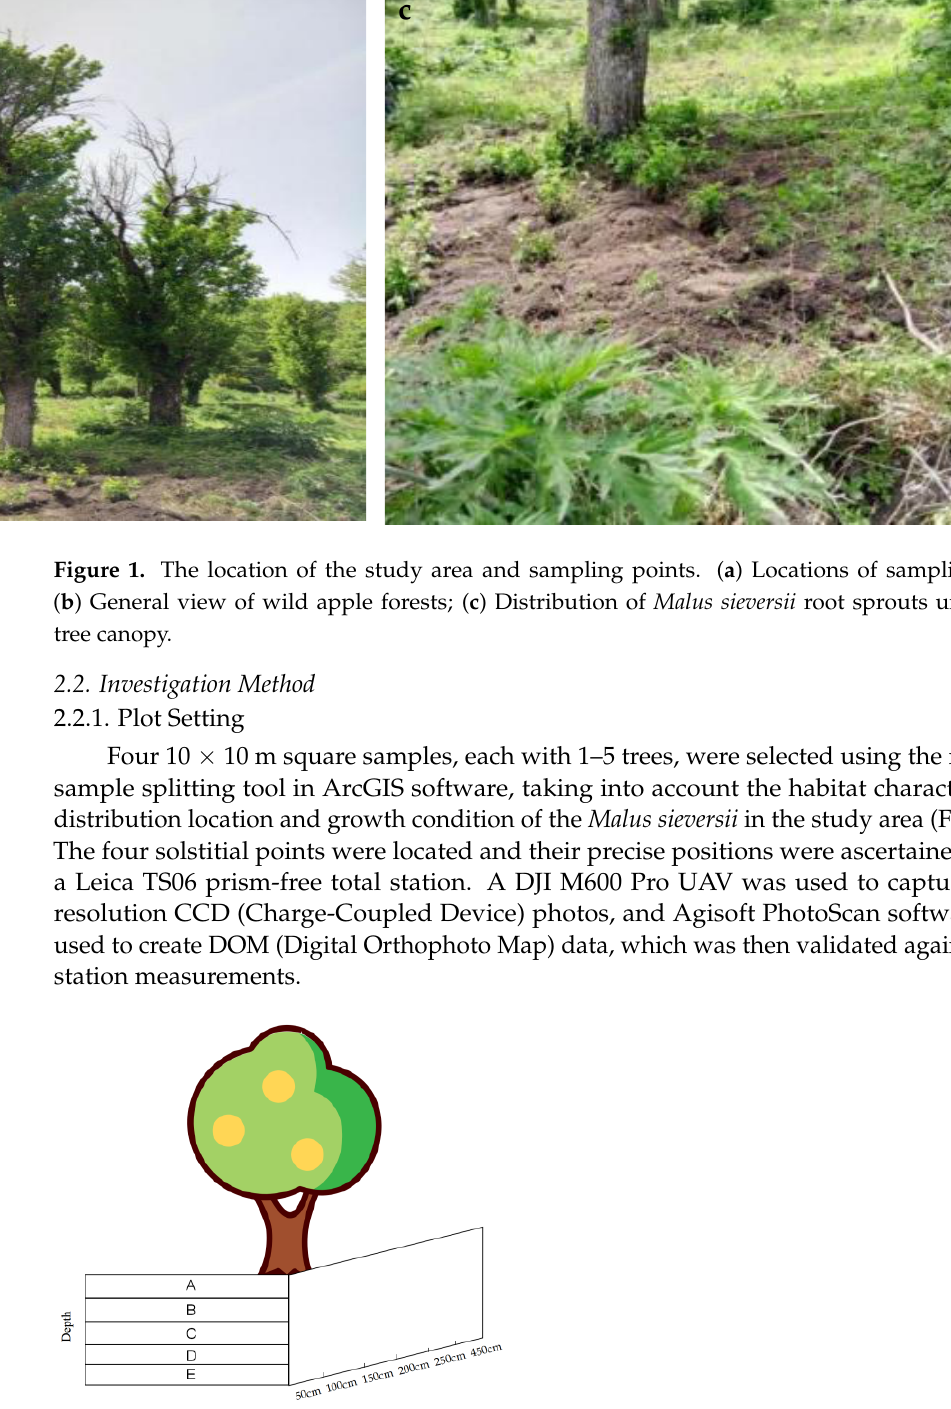
Figure 2. Root survey sample. (A–E represent the depth of root burial in five profiles, respectively: <5 cm, 6–20 cm, 21–40 cm, 40–60 cm, and >60 cm.)